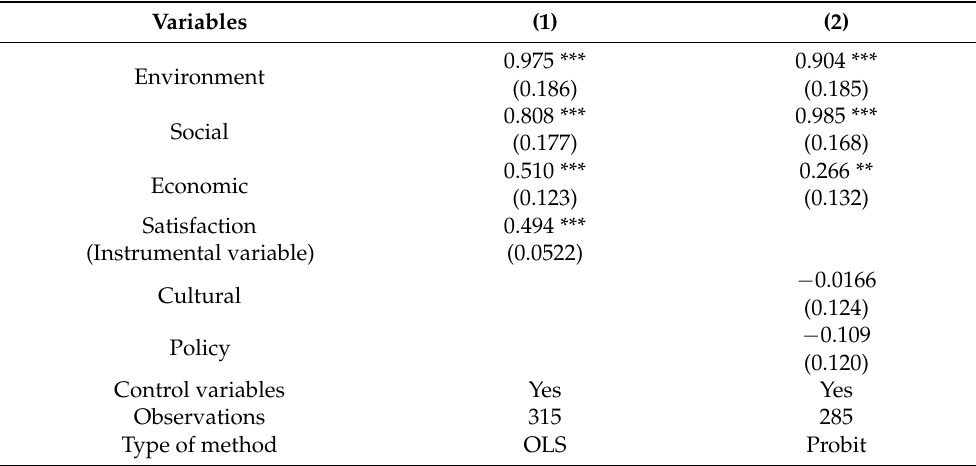
Table 7. Result of robustness